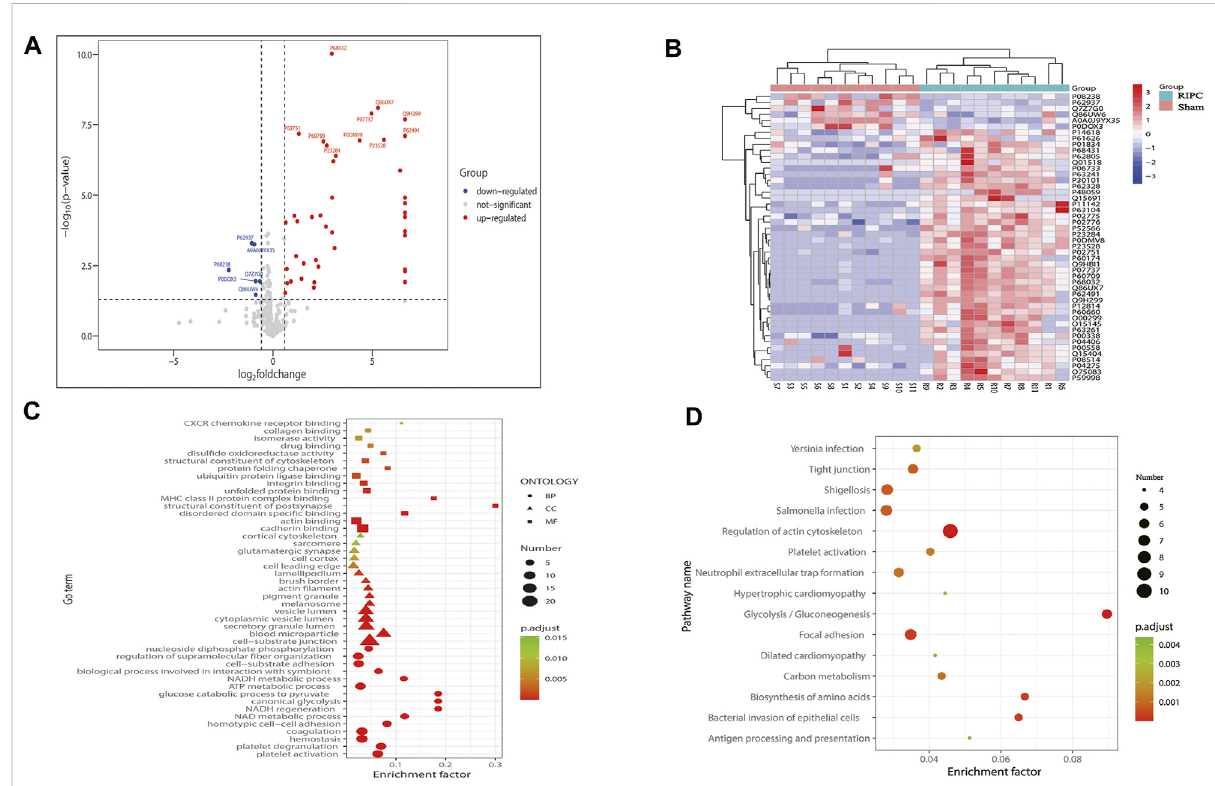
FIGURE 6 (A) Volcano plot of all proteins included in the differential expression analysis. The horizontal axis represents the logarithmic transformation based on2ofthefoldchange,andtheverticalaxis represents thelogarithmictransformationbased on10 ofthe p -value. The reddots and bluedots represent proteins with a fold change greater than 1.5 times (upregulation greater than 1.5 times or downregulation less than 0.67 times) and a p -value less than 0.05, respectively, and the gray dots represent proteins with no signi fi cant difference. The top 10 most signi fi cantly upregulated and downregulated proteins are labeled in the plot. (B) Hierarchical cluster analysis of the 48 differentially expressed proteins. A tree heat map is used to represent the hierarchical clustering results, with each row representing an individual protein and each column representing an individual sample. Protein expression values are standardized in the heatmap and the relative expression levels of the differentially expressed proteins are shown in different colors, in which the colors closer to red represents a relatively high expression level, and colors closer to blue represents a relatively low expression level. RIPC-(1 – 11) represent the RIPC group, and sham-(1 – 11) represent the sham group. (C) GO functional enrichment analysis of the 48 differentially expressed proteins. The top 15 most signi fi cantly enriched GO terms of each category are showed in the plot.Thehorizontalaxisrepresentstheenrichmentfactor,andtheverticalaxisrepresentstheenrichedGOfunctionclassi fi cations,whicharedivided intothreecategories:biologicalprocess(BP),molecularfunction(MF),andcellularcomponent(CC).Theshapeofthepatterningstandsfordifferent GO terms. The color of thepatterning represents the signi fi cance of the enriched GO term. The closer the color is to red, the smaller the p. adjustis, and the higher the enrichment signi fi cance of the analysis is. The size of the patterning represents the number of differentially expressed proteins involvedinacertainGOterm. (D) KEGGpathwayanalysisofthe48differentiallyexpressedproteins.Thetop15mostsigni fi cantlyenrichedpathways are shown in the plot. The horizontal axis represents the enrichment factor, and the vertical axis represents the signi fi cantly enriched KEGG pathways. The color of the dot represents the signi fi cance of the enriched KEGG pathway. The closer the color is to red, the smaller the p. adjust is, and the higher the enrichment signi fi cance of the KEGG pathway is. The size of the dot represents the number of differentially expressed